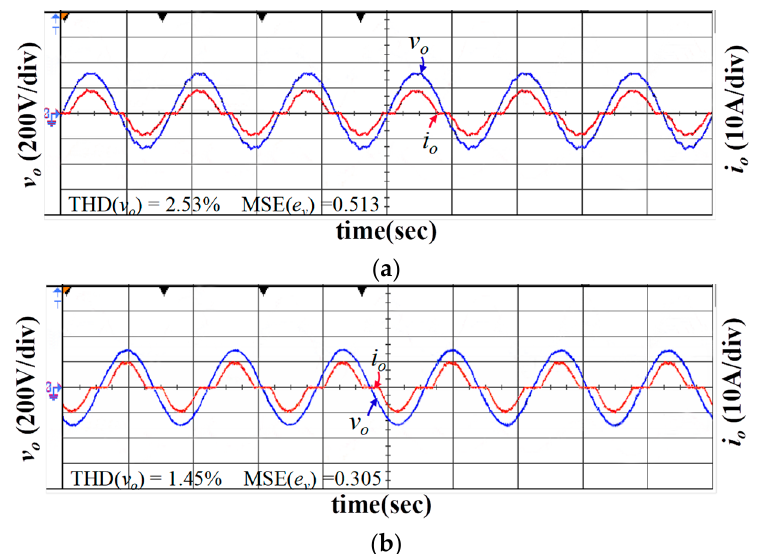
Figure 11. Experimental results under nonlinear load: ( a ) SMC; ( b ) AFSMC.